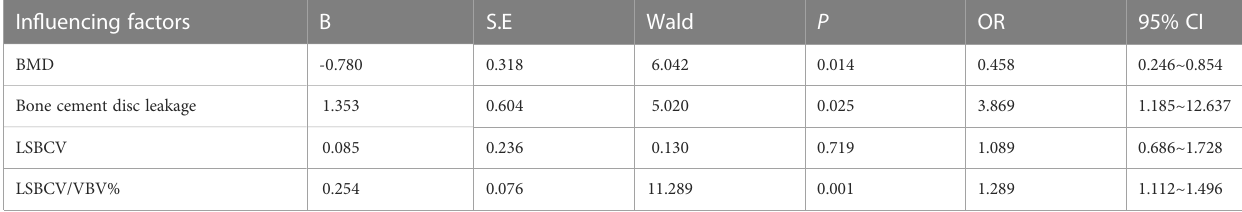
TABLE 2 Multifactorial logistic regression analysis that affects